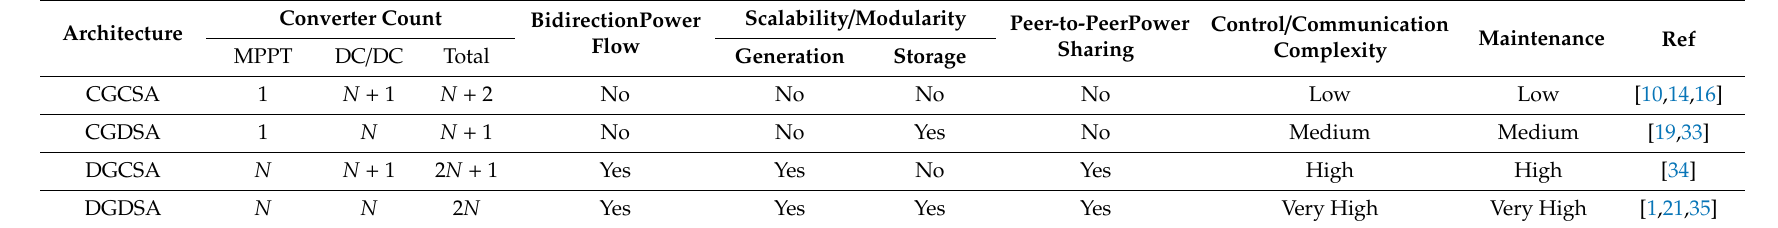
Table 1. Comparison of various features for rural photovoltaic (PV) direct current (DC) microgrid